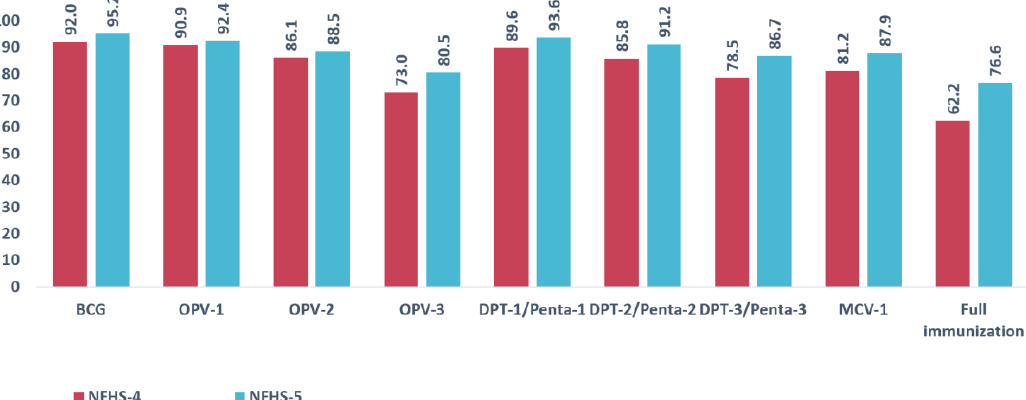
Figure 2. Antigen wise coverage percentage in NFHS-4 and NFHS-5.